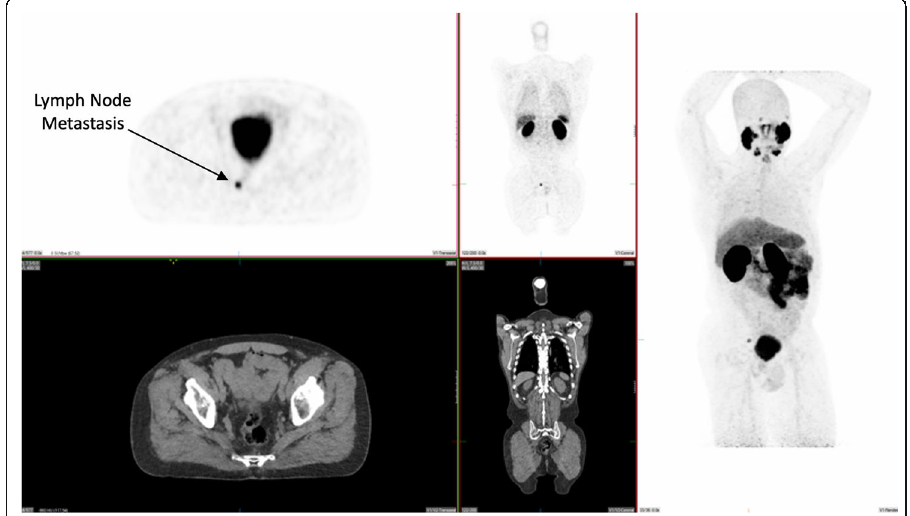
Fig. 7 Images from the first patient scanned with [ 68 Ga]Ga-PSMA-11 labeled with cyclotron produced 68